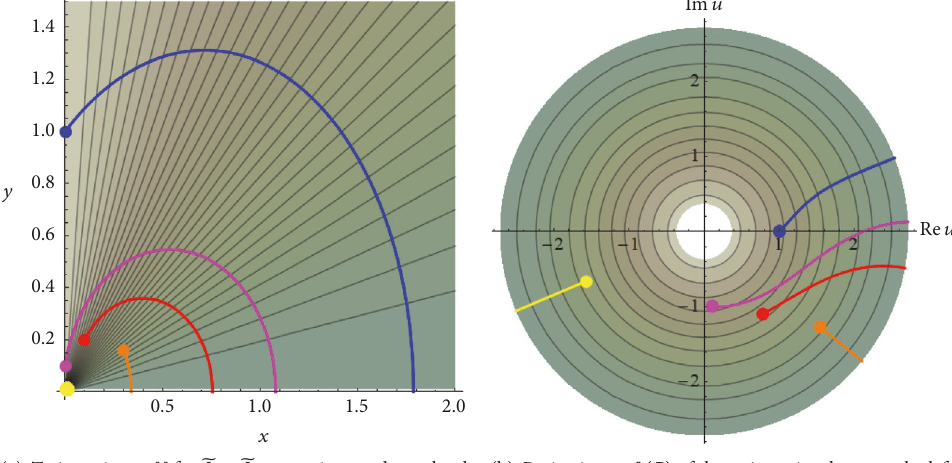
Figure 19: Five trajectories for Φ = Φ − , 𝛼 = 𝑀 0 /3 , and ℓ = 𝜋 2 with initial conditions of Table 1.